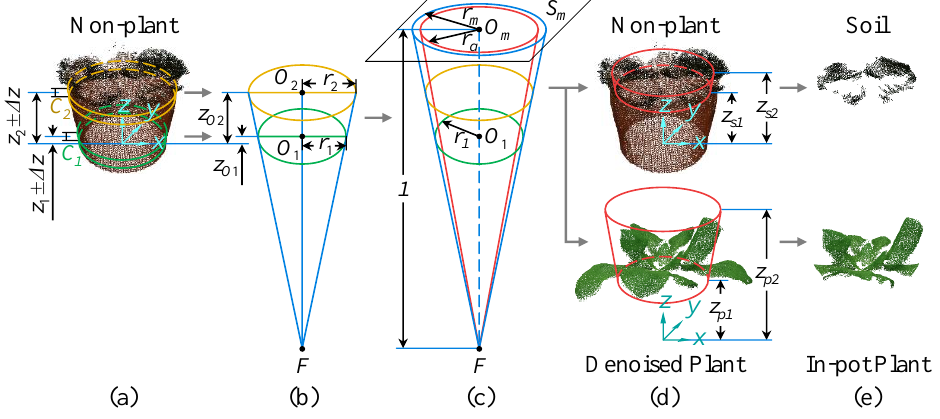
Figure 6. Principle of pot shape feature extraction and in-pot parts segmentation: ( a ) sample points extraction; ( b ) circle fitting and cone apex calculation; ( c ) construction of datum plane and adjusted cone (red); ( d ) in-pot point clouds segmentation; ( e ) segmented results.